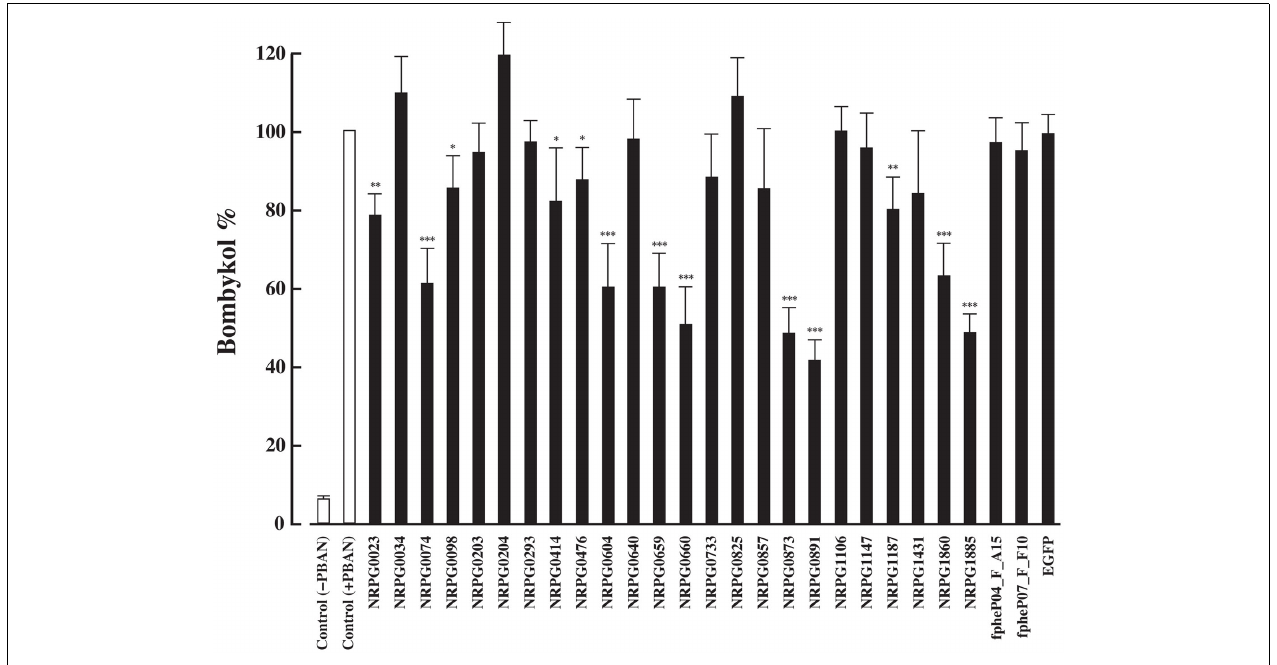
bombykol levels in non-RNAi-treated females following injection with 5pmol PBAN (* p < 0.05; ** p < 0.01; *** p < 0.001). Bars represent mean values ± SD from independent experimental animals ( n = > 15).